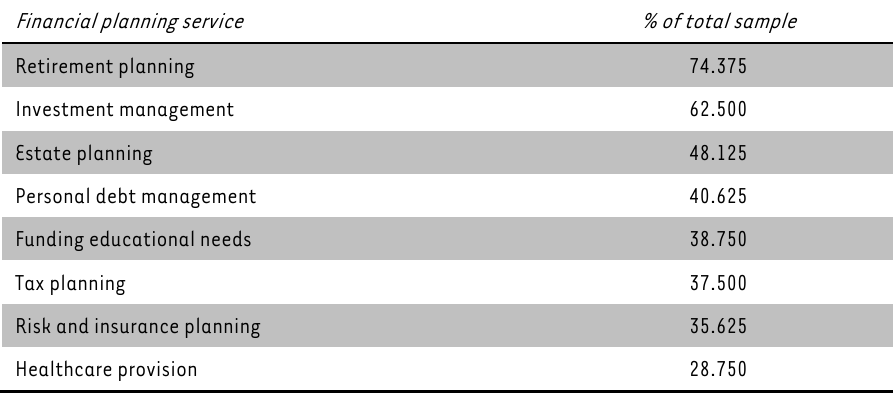
TABLE 4: Financial planning services required by respondents Financial planning service